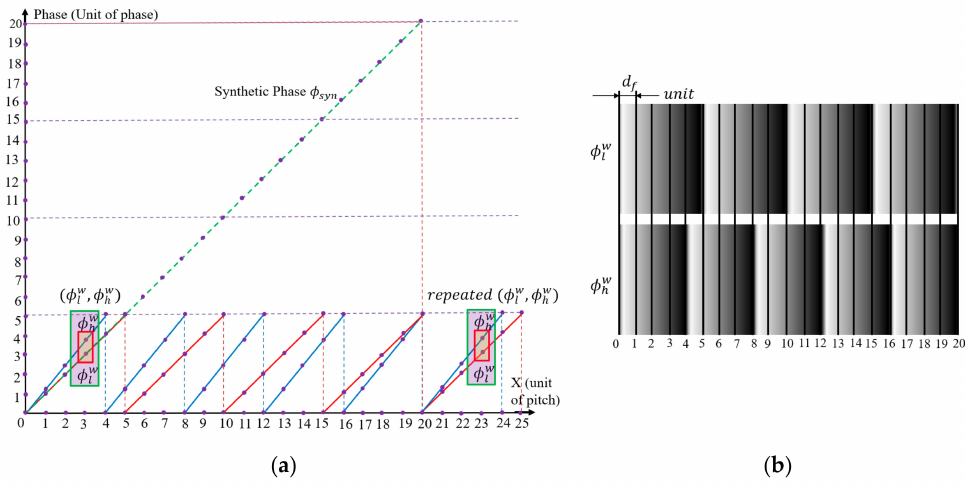
Figure 5. Basic idea of numerical (theoretical) temporal phase unwrapping: ( a ) fraction of wrapped phases with P l (= 5) units and P h (= 4 ) units; ( b ) corresponding wrapped phases, with integer steps indicated by vertical